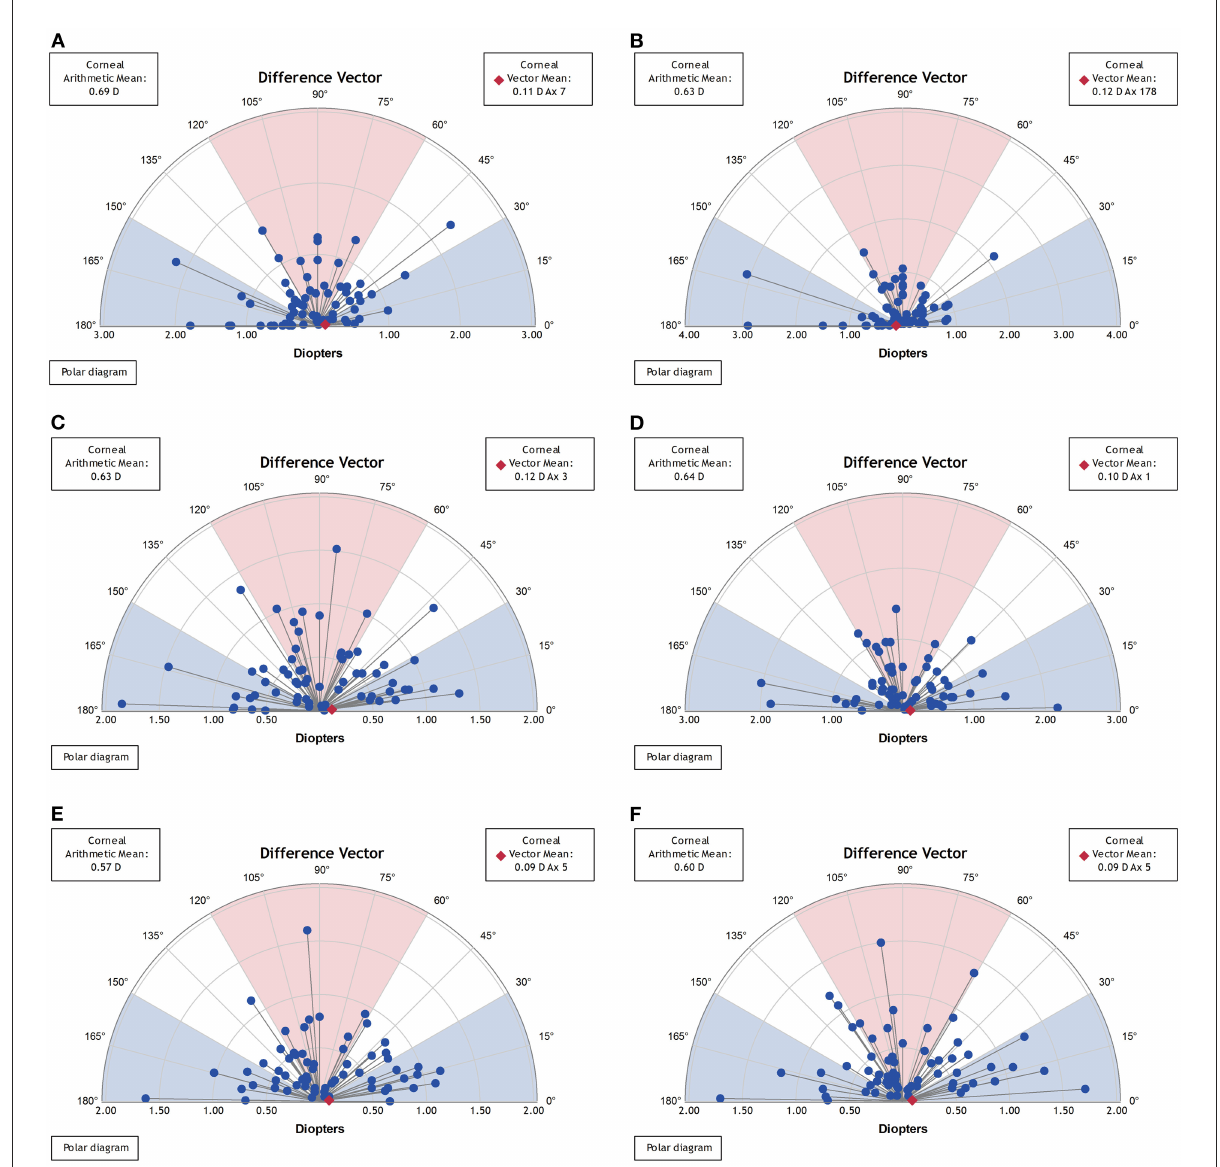
FIGURE5 Vector analysis of postoperative real and synthetic DV in the 1-mm, 3-mm, and 5-mm zones. (A) The real postoperative DV of the 1-mm zone. (B) The synthetic postoperative DV of the 1-mm zone. (C) The real postoperative DV of the 3-mm zone. (D) The synthetic postoperative DV of the 3-mm zone. (E) The real postoperative DV of the 5-mm zone. (F) The synthetic postoperative DV of the 5-mm zone.